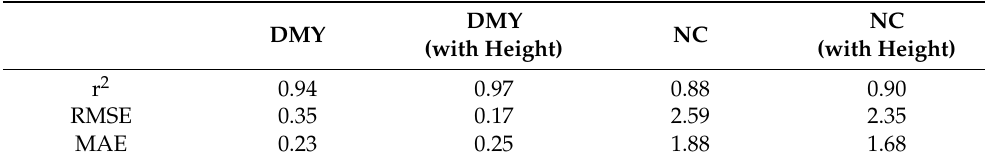
Table 2. Performance of estimation by random forest regressor using statistical parameters of